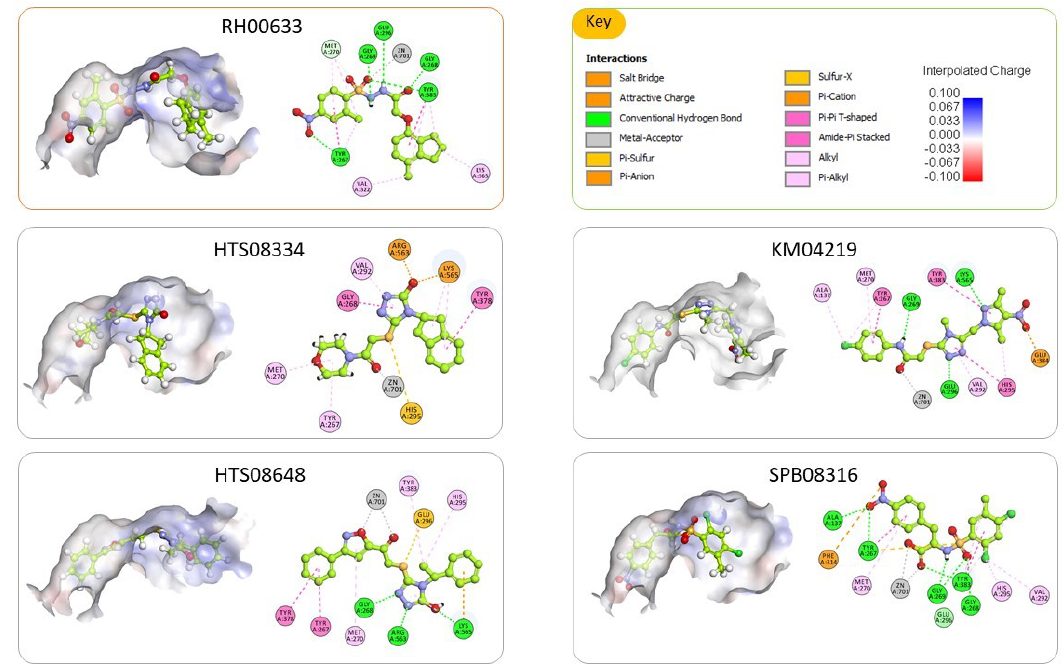
Figure 7. The top ranked docked pose of the five tested compounds. For each compound, there is a 3D depiction of the docked pose showing its orientation within the binding site and a 2D interaction map with the enzyme. The binding site is shown as an interpolated charge surface, and the docked compounds are shown as balls and sticks with carbons colored limon. Residues in the 2D interaction map are shown as disks and colored according to the type of interactions with the